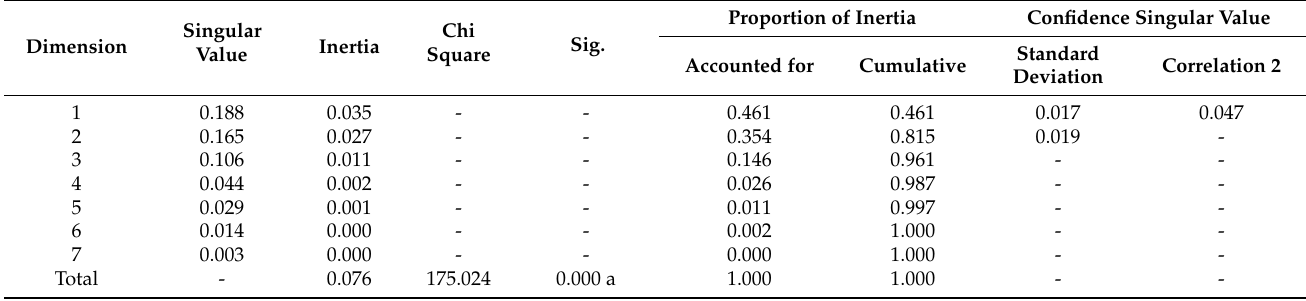
Table 14. A Correspondence Analysis Table between the Interior Landscape Model and Psychological Responses of the Subjects of the Survey According to the GI.